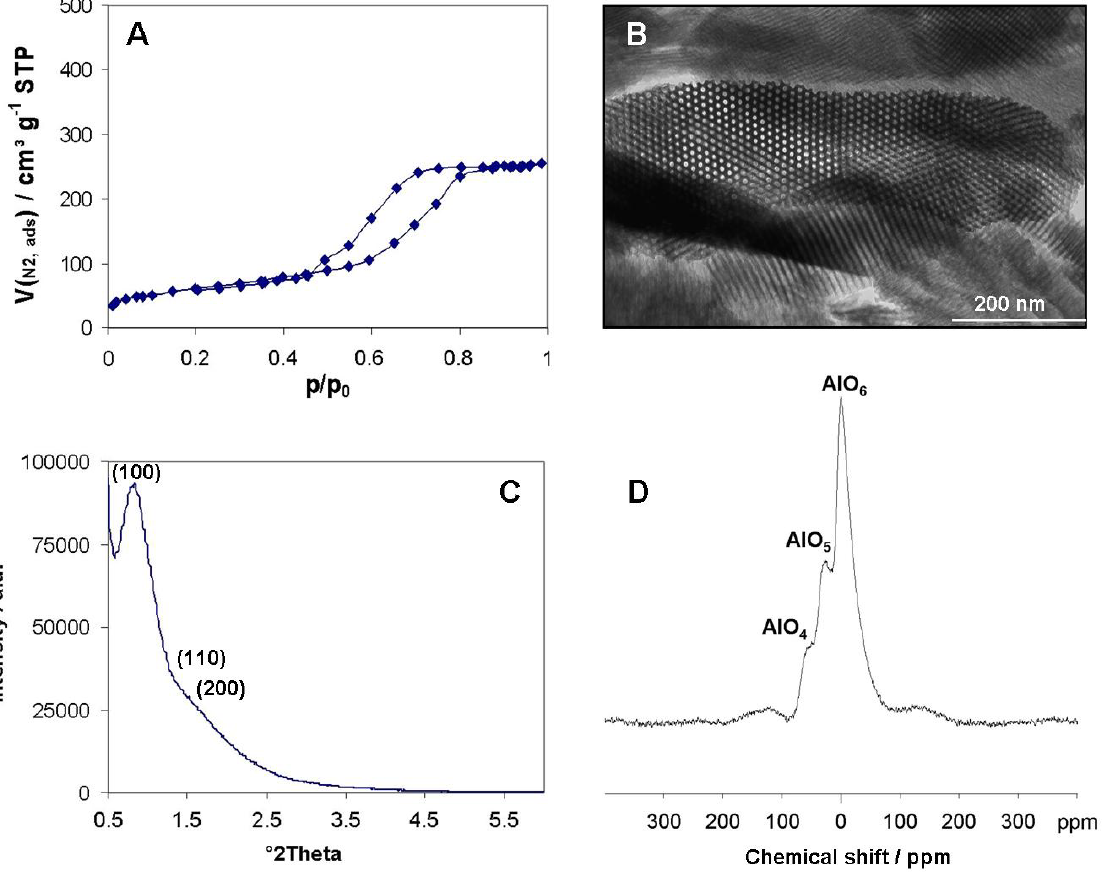
Figure 2. ( A ) Nitrogen sorption isotherm at 77 K of hexagonal mesoporous alumina with amorphous walls; ( B ) corresponding TEM image of the 2D-hexagonally arranged mesopore system; ( C ) Small X-Ray Diffraction recorded in the range showing the hexagonal arrangement; ( D ) 27 Al MAS NMR spectra recorded at a spinning rate of 10